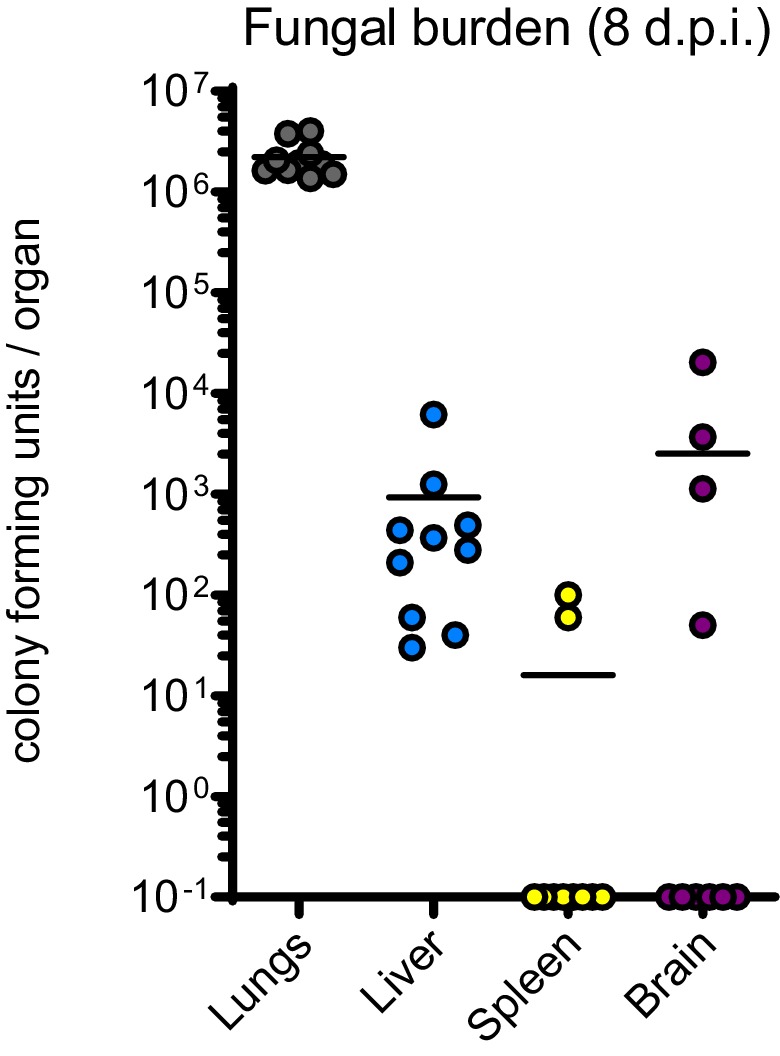
C. neoformans disseminates by 8 days in CD-1 outbred mice.Fungal burden of C. neoformans in CD-1 outbred mice at 8 days post infection.